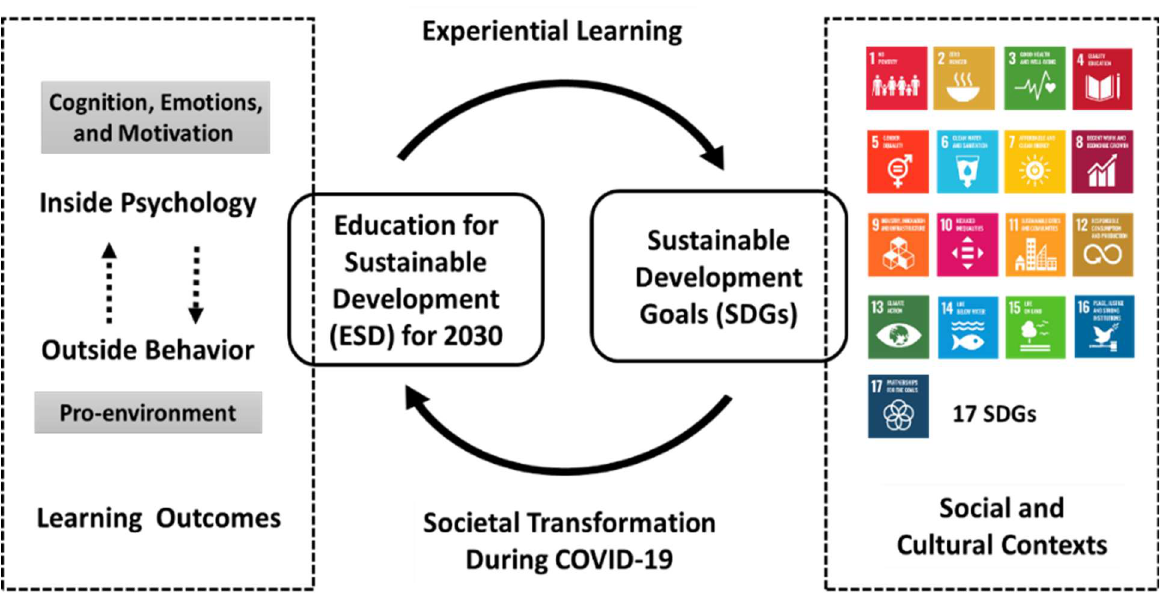
Figure 5. A new developed model explanation on societal transformation through experiential learning in ESD for 2030. The source of the icons of the 17 SDGs were obtained from the UN website [9].